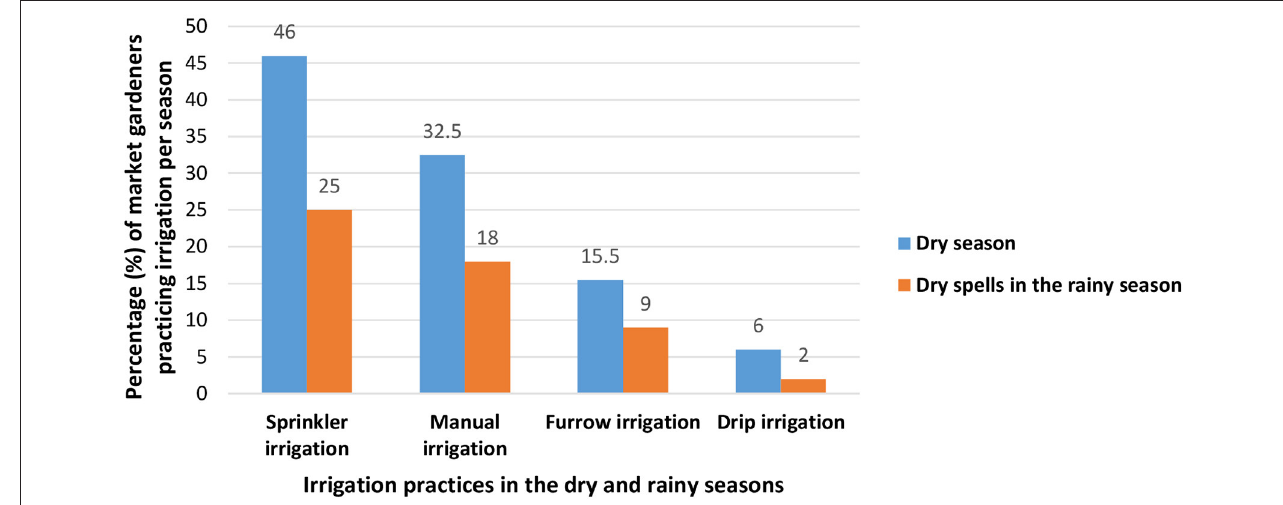
FIGURE 2 | Irrigation practices of market gardeners in the rainy and dry